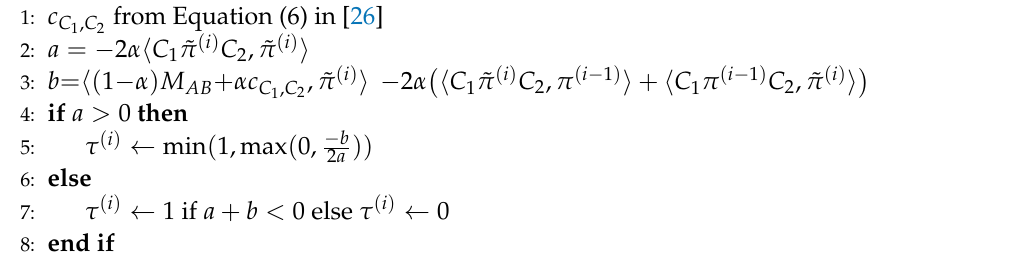
Algorithm 2 Line-search for CG ( q =